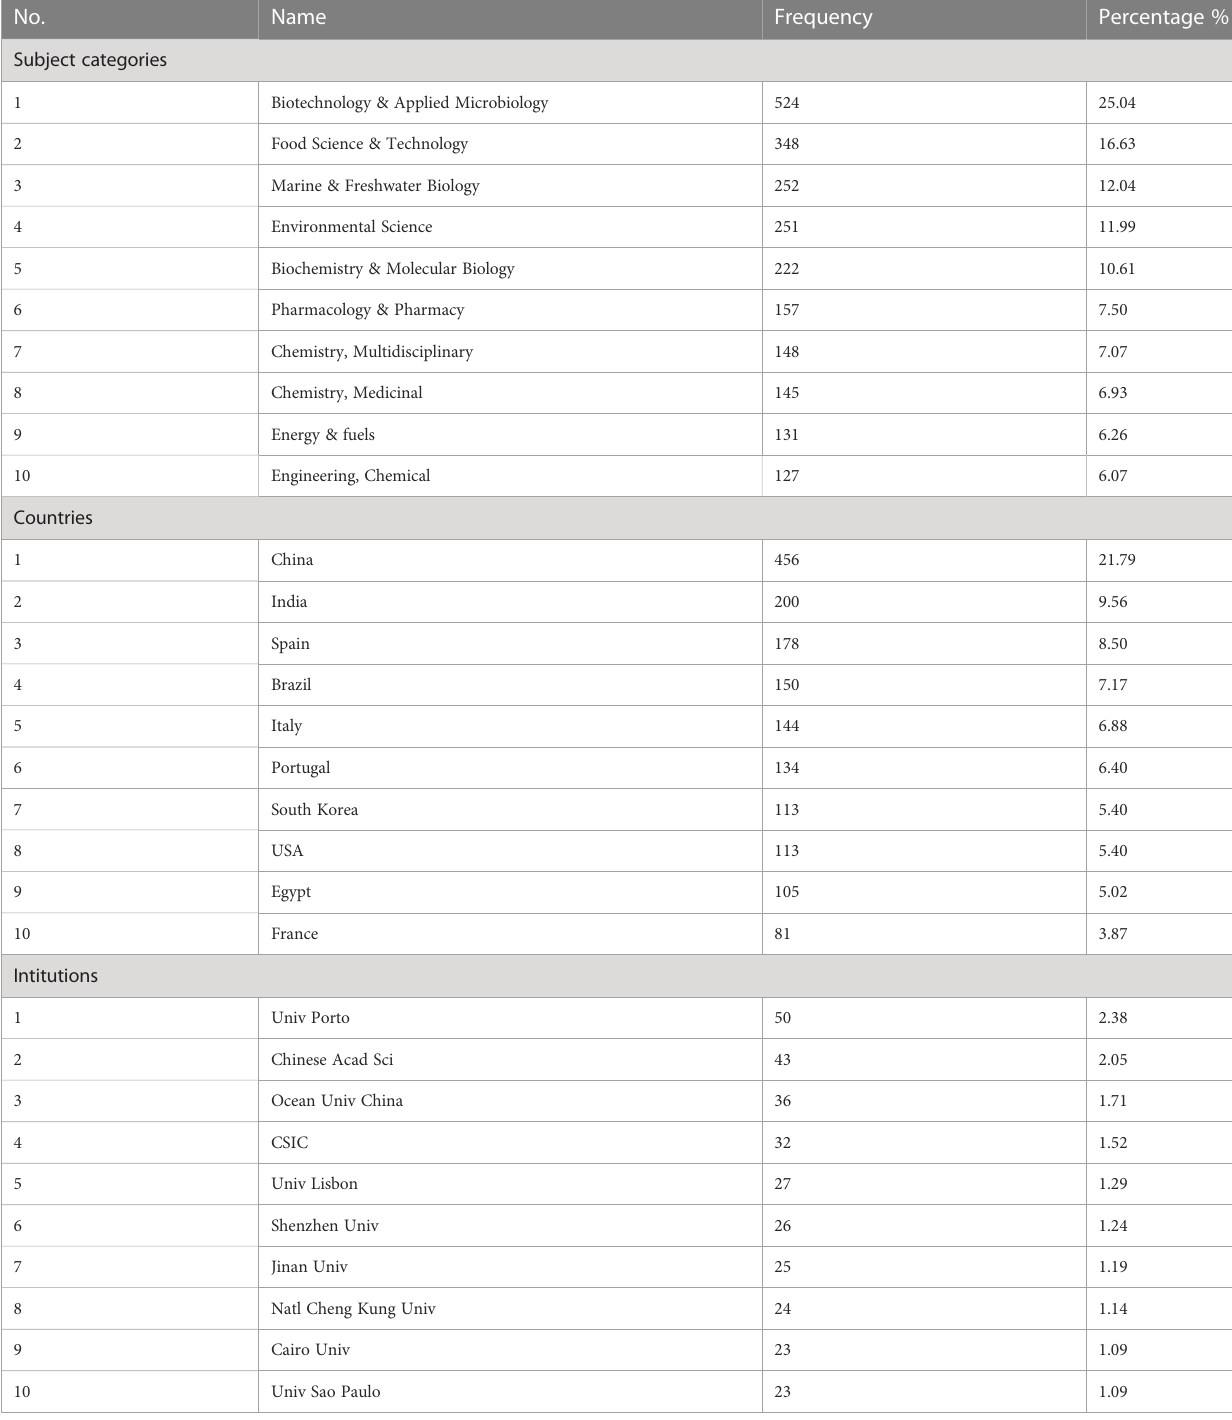
TABLE 1 Top 10 subject categories, countries, and institutions in terms of publications.